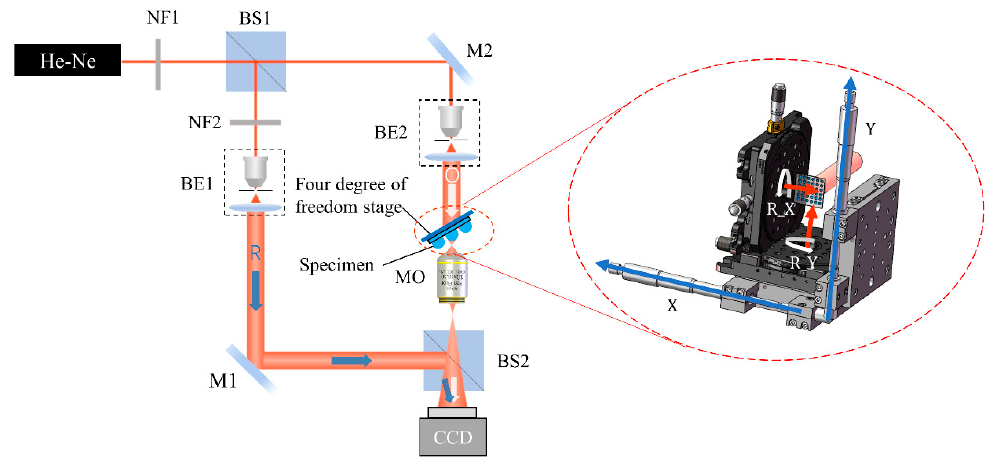
Figure 1. Schematic of the digital holography microscopy (DHM) system setup in transmission configuration with four degree of freedom stage.